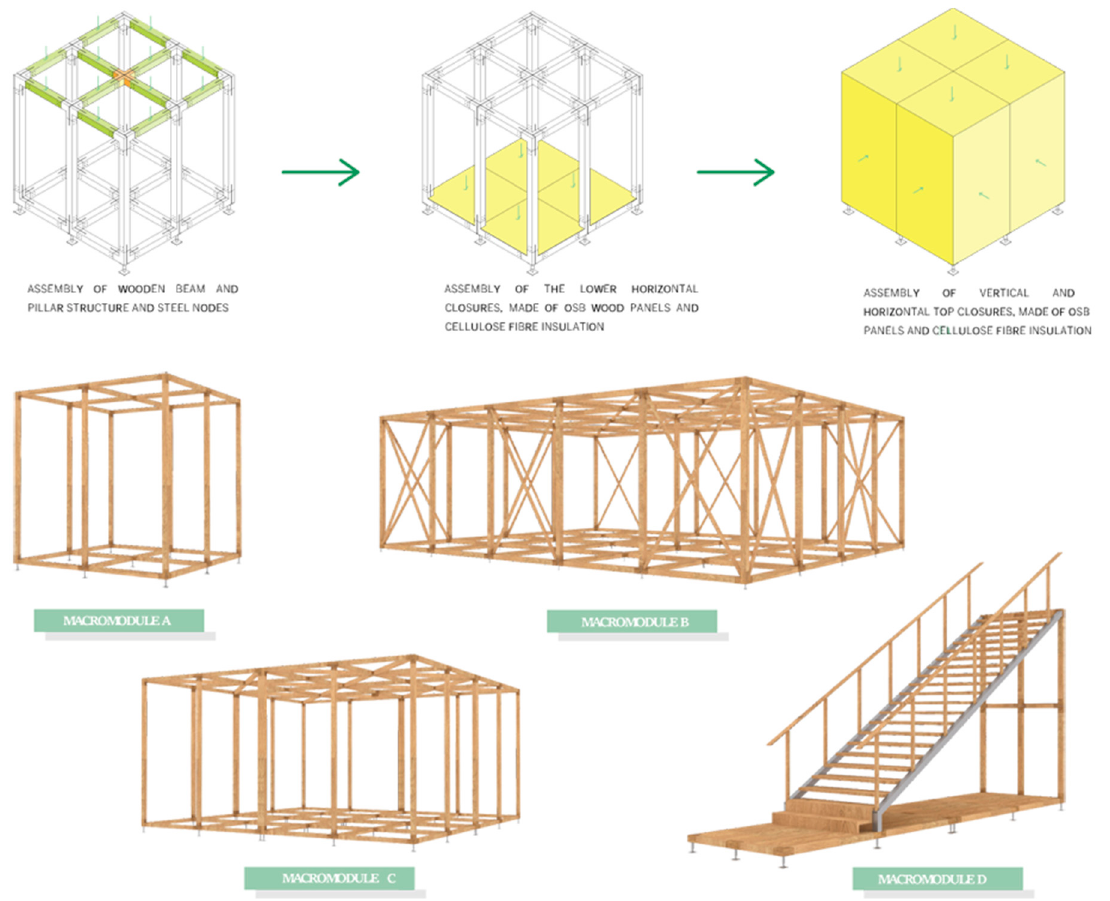
Figure 6. Design of macro-modules resulting from the combination of basic modules that allow for dimensionally and functionally different spaces congruent with the requirements determined in the previous phase and the pre-existence.